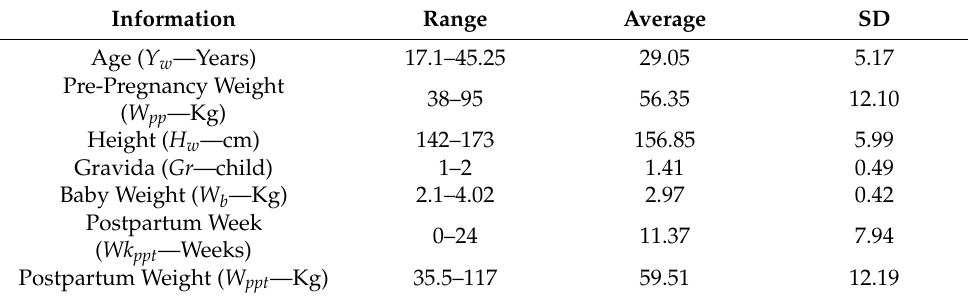
Table 4. Information the postpartum